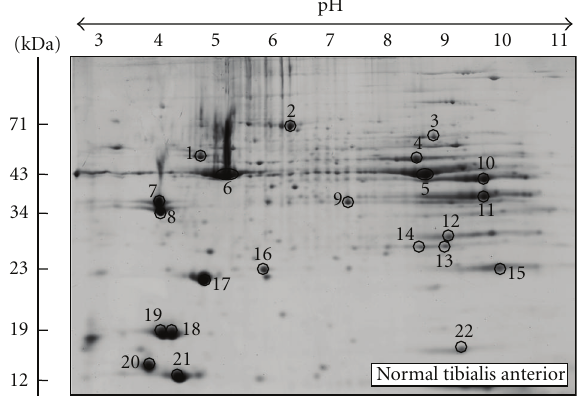
Figure 1: Two-dimensional gel electrophoretic analysis of normal mouse tibialis anterior muscle. Shown is a fluorescent RuBPs- stained gel of total extracts from 8 weeks old tibialis anterior muscle. Major protein spots are marked by circles and are numbered 1 to 22. See Table 1 for the mass spectrometric identification of 2D landmark proteins that do not change during aging of the mdx animal model of Duchenne muscular dystrophy. The pH values of the first dimension gel system and molecular mass standards of the second dimension are indicated on the top and on the left of the panels,